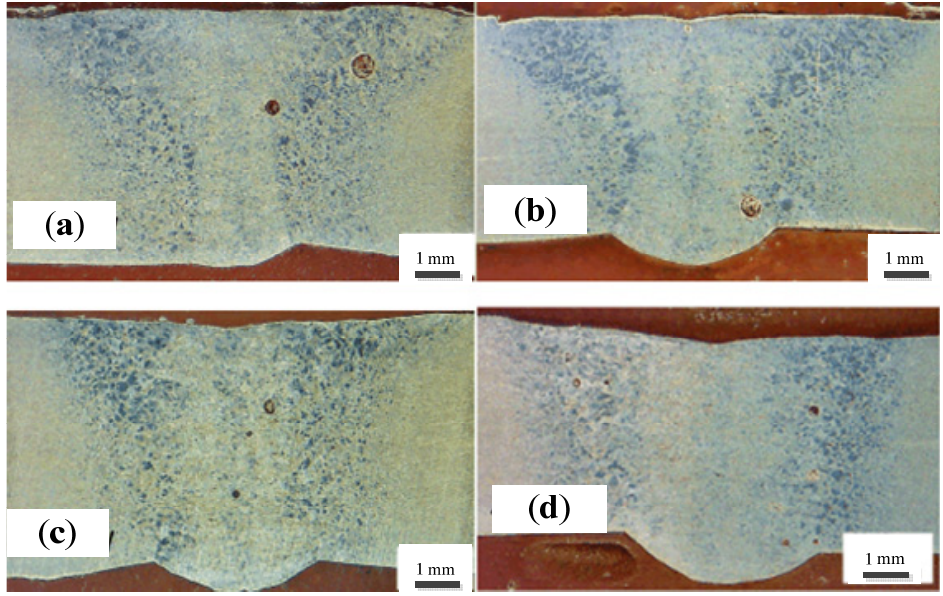
Figure 8. The cross-section morphology under different laser power: ( a ) 1600 W, ( b ) 1700 W, ( c ) 1800 W, ( d ) 1900 W.